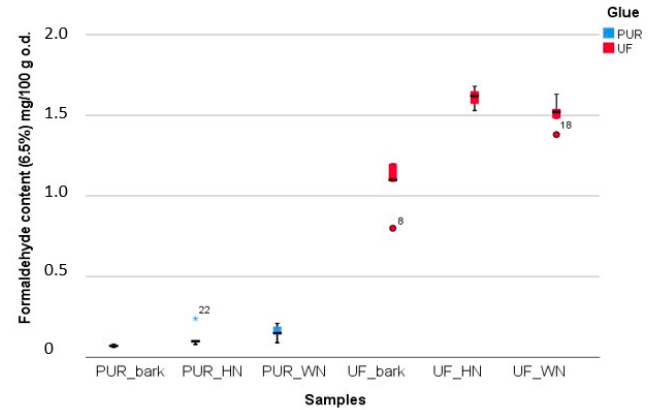
Figure 2. Free formaldehyde content for both the measured and corrected perforator values (EN 120:2011) of samples of walnut and hazelnut shell boards compared with larch bark panels from [53].